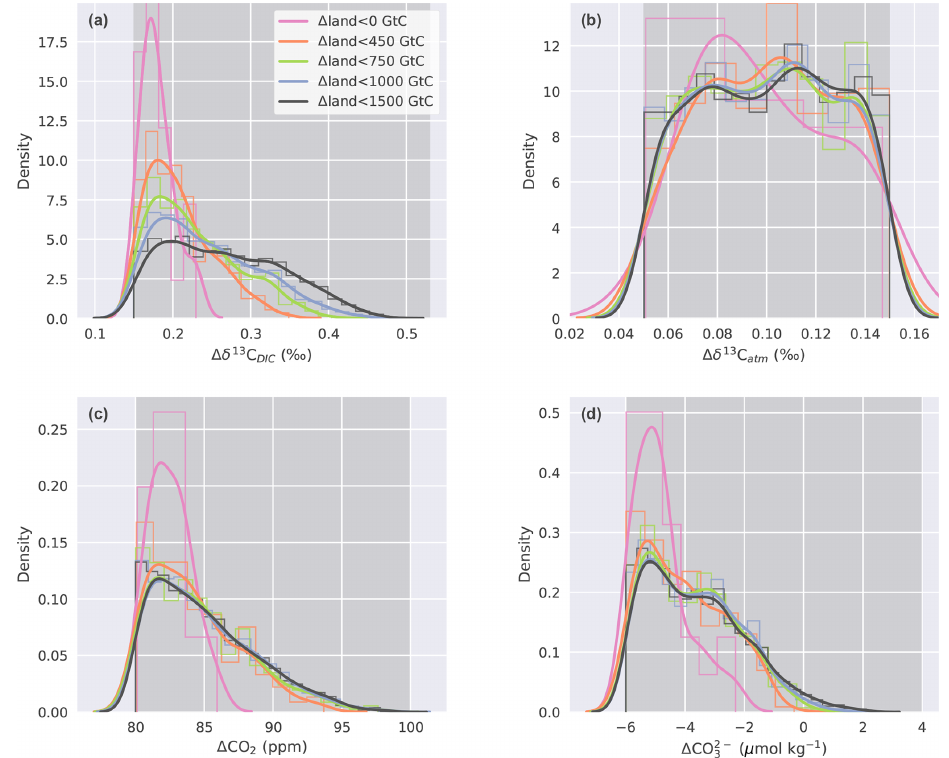
Figure 6. Histogram (thin lines, normalized) and kernel density estimate (thick lines) of (a) (cid:49)δ 13 C DIC , (b) (cid:49)δ 13 C atm , (c) (cid:49) CO 2 , and (d) (cid:49) CO 2 − values for parameter combinations calculated with the emulator that fulfill the observational constraints. Different colors in all four 3 panels correspond to subsamples divided along (cid:49) land values that are smaller than 1500, 1000, 750, 450, and 0GtC. Darker grey shading indicates the range of the respective observational